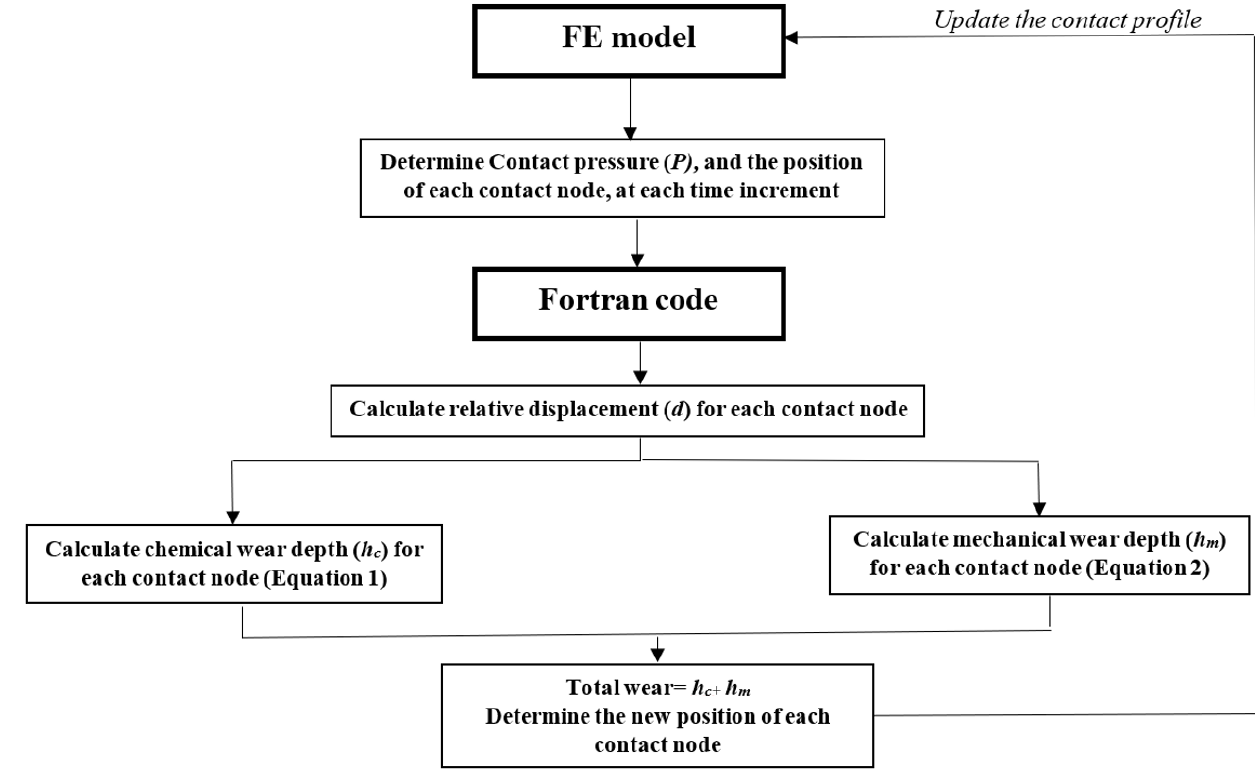
Figure 1. The algorithm of the FE model and FORTRAN code.